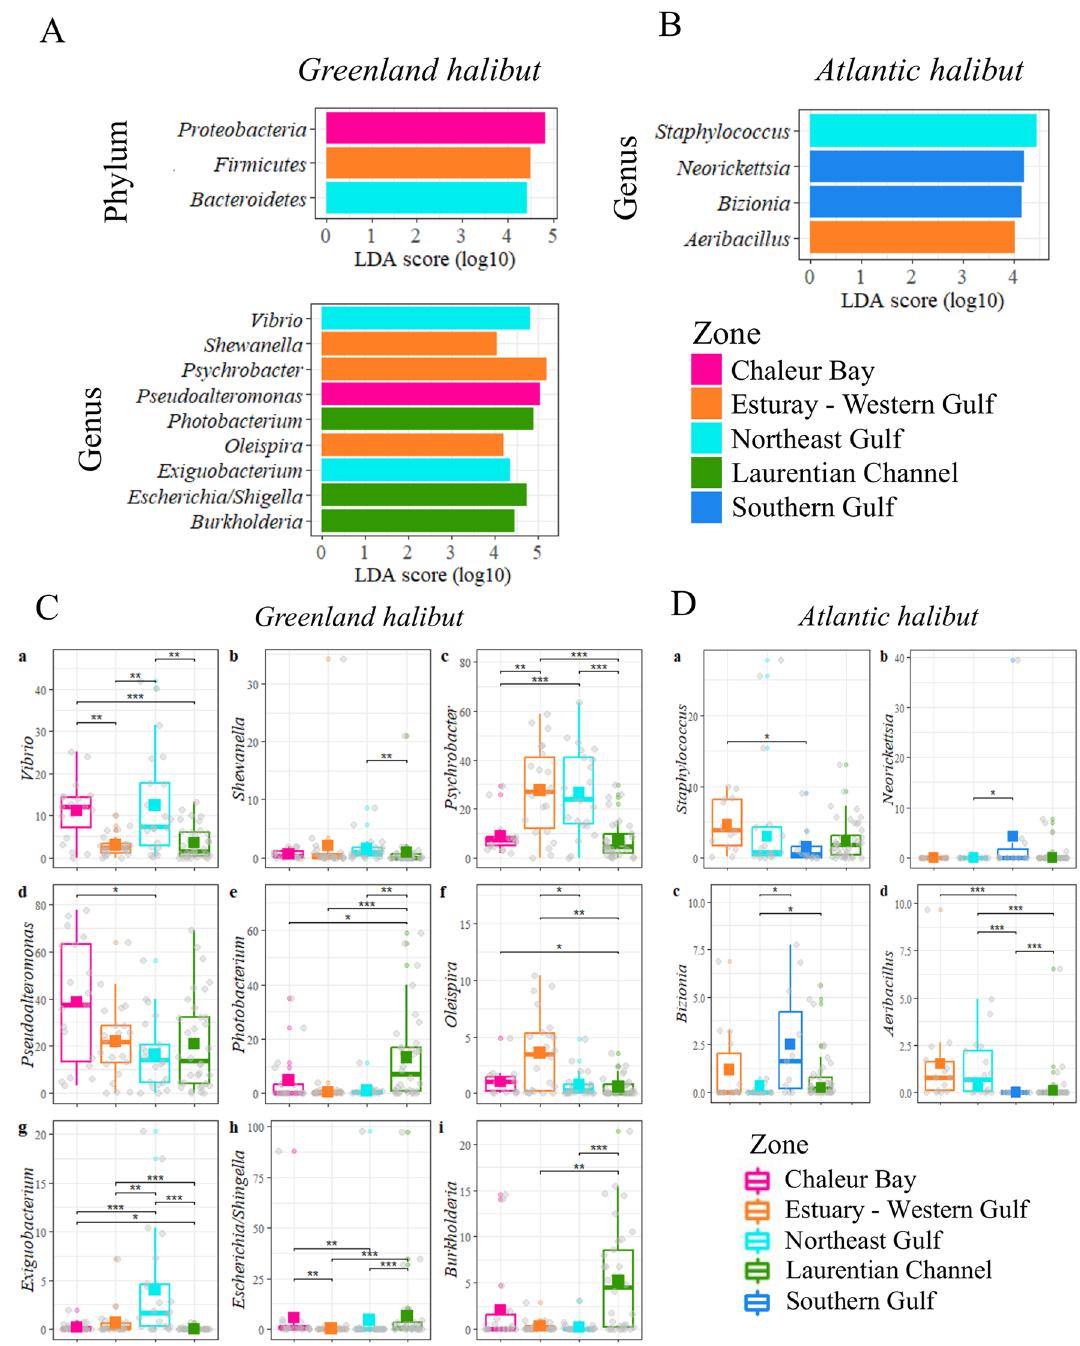
Figure 7. Spatial analysis. LEfSe analysis of the blood microbiome showing the significantly different taxa in ( A ) Greenland and ( B ) Atlantic halibut according to their localization. ( C and D ). Relative abundance of the discriminative genera in Greenland and Atlantic halibut. (*) p < 0.05; (**) p < 0.01; (***) p < 0.00. Greenland halibut: Estuary–Western Gulf, n = 22, Chaleur Bay, n = 19, Northeast Gulf, n = 22, Laurentian Channel, n = 34. Atlantic halibut: Estuary–Western Gulf, n = 14, Southern Gulf, n = 11, Northeast Gulf, n = 17, Laurentian Channel, n = assessed by visual characterization, the individual’s sex could have been genetically determined with the blood samples 55,56 . In addition to ethical and logistical considerations, recent studies in humans and other species have shown that defining the core blood microbiome using a single drop of blood exhibits considerable potential as a disease biomarker 16,20 . The circulating microbiome can be used to facilitate the detection of pathogens, given that pathogenic (and symbiotic) bacteria are not exclusively found in the gut but also in other tissues. It is important to note, however, that the presence of bacteria in the blood is not de facto associated with a disease state, as